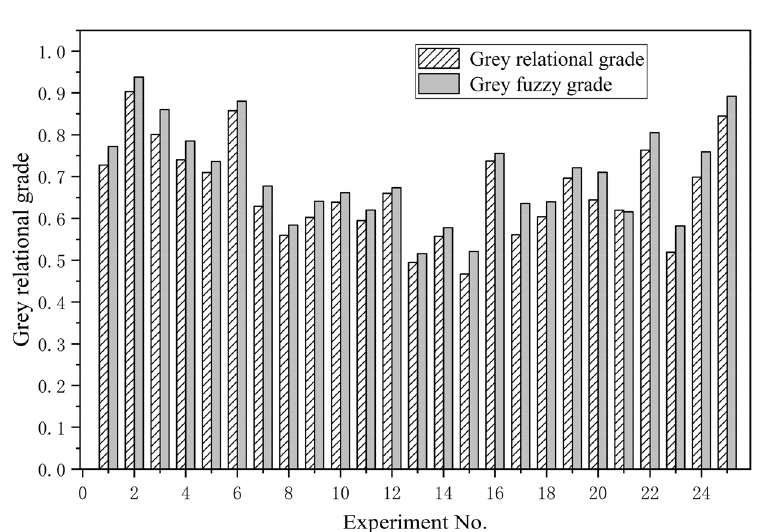
Figure 8. Comparison between the GFGs and the